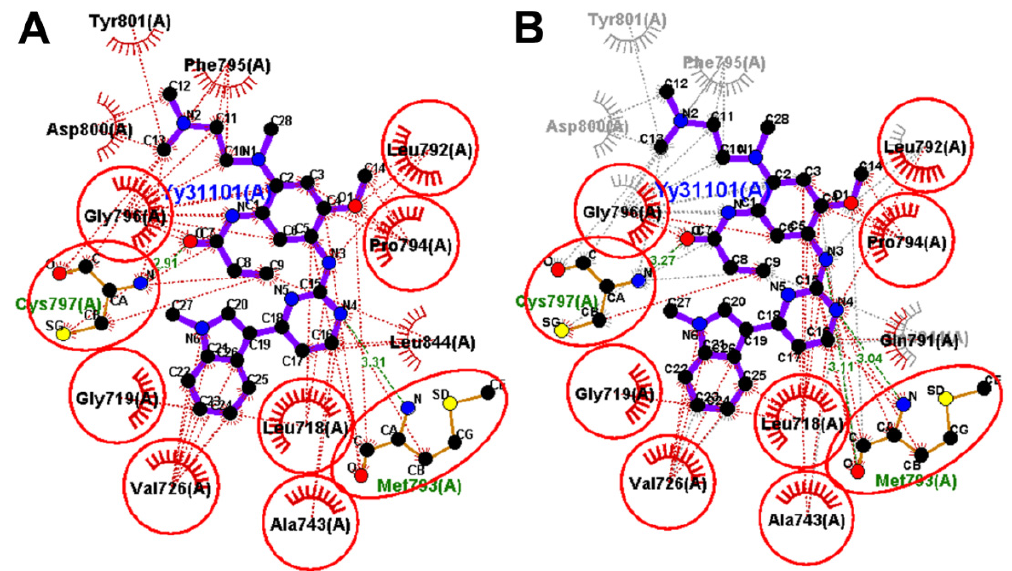
Figure 11. Binding interactions of osimertinib (shown as purple sticks) into EGFR (pdb: 4ZAU): ( A ) redocked osimertinib; ( B ) superposed LigPlot view of the co-crystallized osimertinib (purple sticks) overlaid with the redocked osimertinib (gray sticks), the red circles/ ellipses show the equivalent binding interactions of the two molecules, hydrogen bonds are shown as olive green dotted lines and hydrophobic interactions are shown in brick red dotted lines.